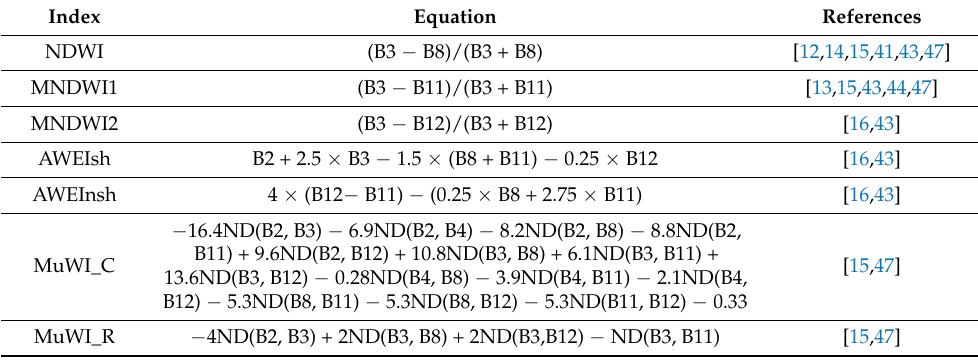
Table 1. Spectral water indices and their derivative equations. Bi refers to the particular Sentinel-2 band i; ND(i, j) denotes the normalized difference of Sentinel-2 band i and band j.